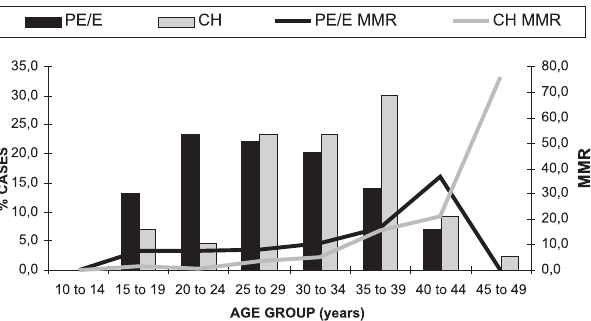
Table 3 - Distribution of the 142 cases of obstetric maternal death resulting from hypertensive disorders in pregnancy